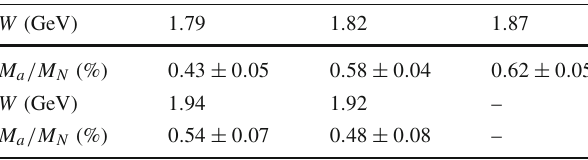
( 3 . 50 ± 0 . 70 ) %. Combined with the results of this work, the trace anomaly contribution obtained from the light vec- tor meson and heavy vector meson is listed in Table 6.